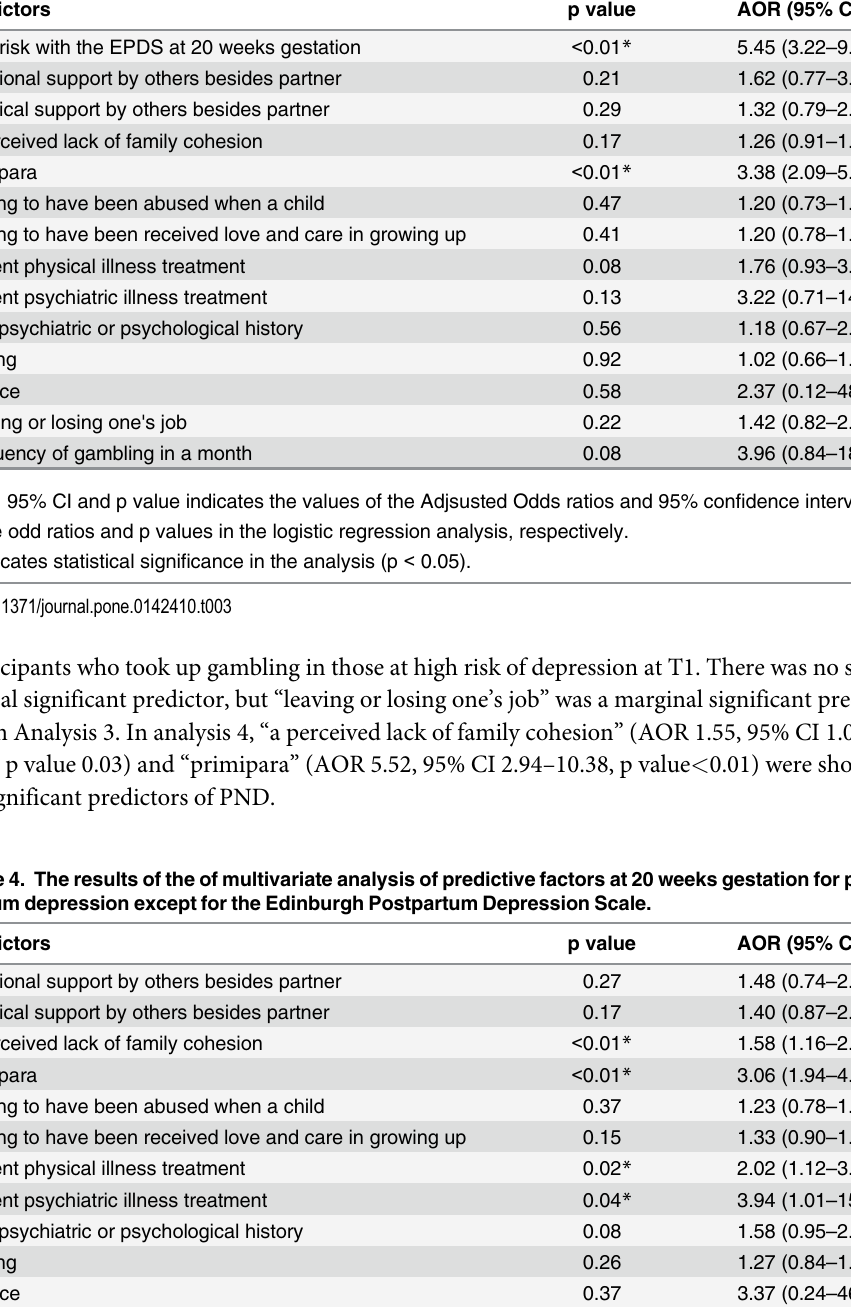
Table 3. The results of the multivariate analysis of predictive factors at 20 weeks gestation for post- partum depression. Predictors p value AOR (95% CI) High risk with the EPDS at 20 weeks gestation Emotional support by others besides partner